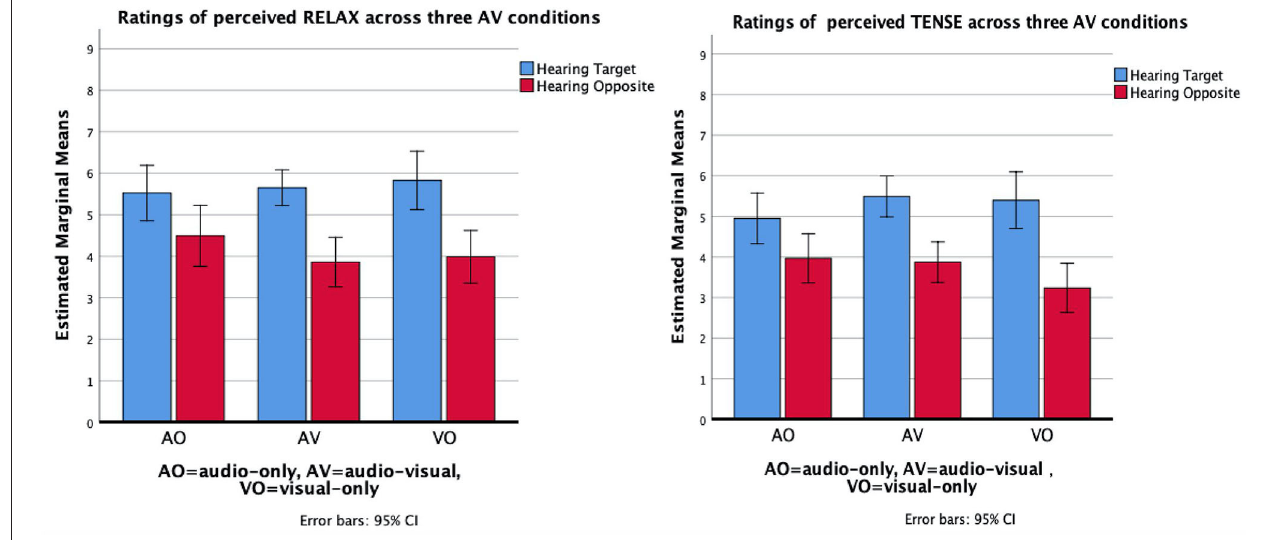
FIGURE 4 | Mean values of the evaluation of Relaxed timbre (left) and Tense timbre (right) across three AV stimuli found by averaging the pianist / piece factor. Error bars represent confidence intervals. contrasting performances—e.g., the mean difference in size evaluation between hearing bright timbre and hearing dark timbre. Significant differences are shown with ∗ .